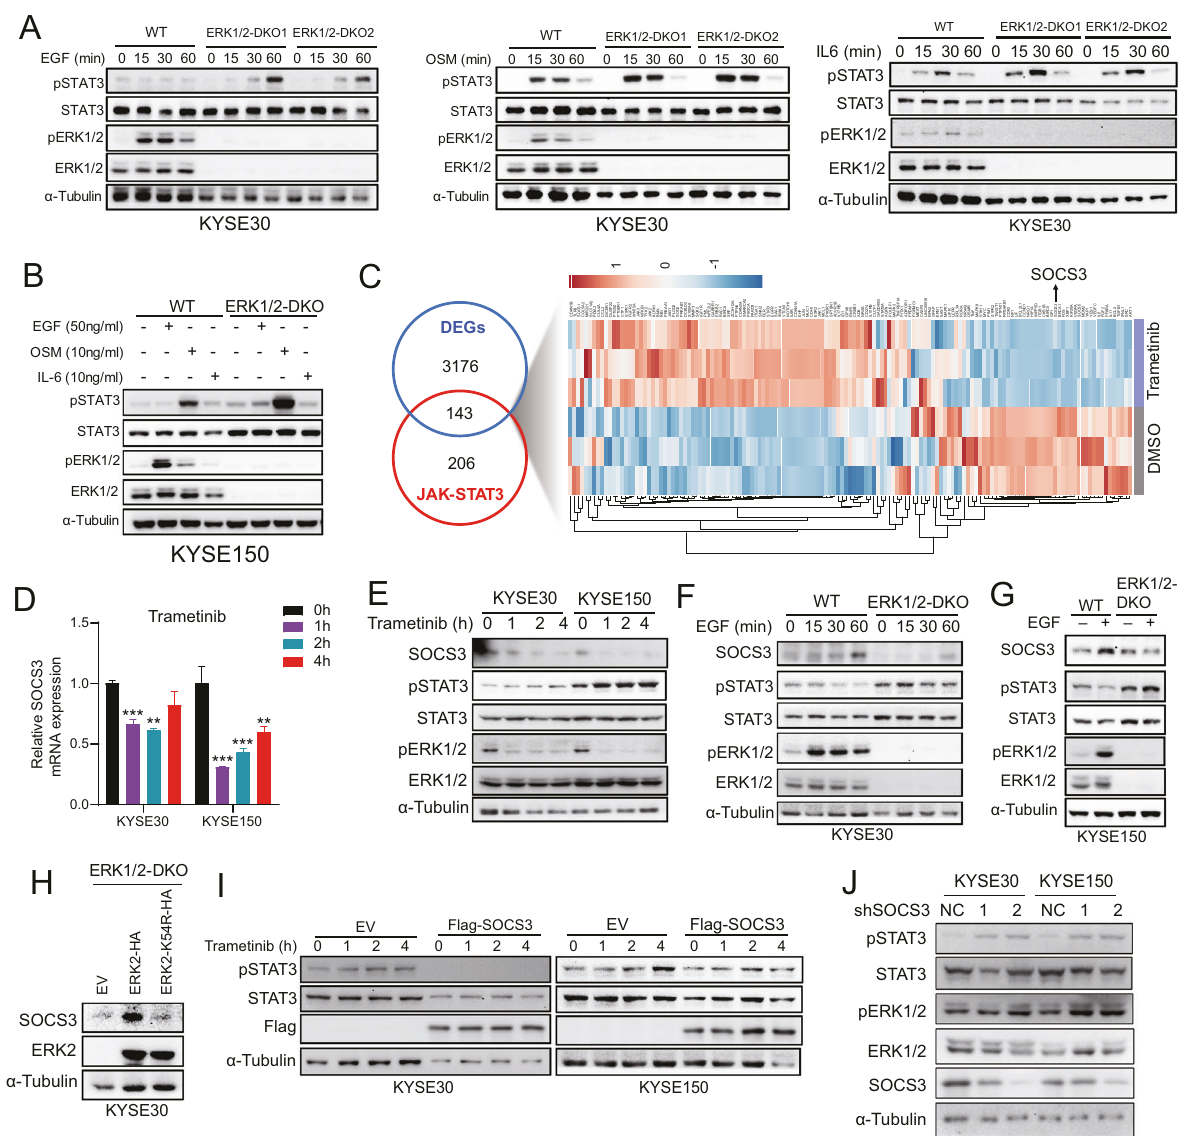
Fig. 4 MEKi results in STAT3 phosphorylation, which occurs through SOCS3 downregulation. A Western blotting shows the expression of pSTAT3 and pERK in KYSE30 WT, ERK1/2-DKO-1, and ERK1/2-DKO-2 after EGF (50 ng/ml), OSM (10 ng/ml), or IL-6 (10 ng/ml) treatment. B KYSE150 WT and ERK1/2-DKO cells were treated with EGF (50 ng/ml), OSM (10 ng/ml), or IL-6 (10 ng/ml) for 1 h. Expressions of pSTAT3 and pERK were determined using western blotting. C RNA-seq heat map analyses of differentially expressed genes (DEGs) involved in the JAK- STAT3 signaling pathway after trametinib or DMSO treatment. A fold change cutoff of log2 < − 0.58 or >0.58 and a p value cutoff of P < 0.05 were selected and overlapped for JAK-STAT3 signaling pathway genes. D qRT-PCR results show the transcription level of SOCS3 mRNA after trametinib treatment at various time points. Error bars represent the mean ± SD. ** P < 0.01, *** P < 0.001. E KYSE30 and KYSE150 cells were incubated with trametinib (1 μ M) for 0, 1, 2, 4 h, immunoblotted for SOCS3 expression. F , G Western blotting results show the expression of SOCS3 after EGF (50 ng/ml) treatment in WT, ERK-DKO KYSE30 ( F ) and KYSE150 ( G ) cells. H KYSE30 ERK1/2-DKO cells stably expressing EV, ERK2-HA, and ERK2-K54R-HA were used for western blotting to determine SOCS3 expression. I Western blotting results show the expression of pSTAT3 and Flag-SOCS3 in KYSE30 and KYSE150 cells transduced with EV or Flag-SOCS3. Trametinib (1 μ M) treatment was applied at various time points. J Western blotting results show the expression of pSTAT3 and pERK1/2 in KYSE30 and KYSE150 cells infected with shNC or shSOCS3 lentiviral with two target cell-dependent regulation and tumor cell develop different MEKi leads to autocrine activation of STAT3 via FGFR and IL-6 resistance mechanisms that drive a feedback loop for STAT3 receptors in mutationally activated EGFR-driven non-small-cell activation in response to stress. While the crosstalk between lung cancers [37]. STAT3 inhibition (STAT3i) resulting in ERK STAT3 and ERK signaling is complex, we sought to identify its role activation may be involved in other mechanisms in ESCC and has in mediating tumor cell target therapy in our ESCC models after been studied in pancreatic cancer [34]. Recently, Nagaraj et al. combined inhibition. Indeed, both STAT3 and MEKi resulted in showed an inverse correlation between pSTAT3 and pERK1/2 in decreased cell proliferation not only through inhibition of the pancreatic cancer, in which STAT3i results in ERK activation STAT3 and ERK signaling feedback but also by inducing through the TACE-AREG-EGFR axis [34]. These studies suggest that senescence via increasing cell cycle arrest and SASP (Fig. 6). the intracellular complexity of signaling pathway crosstalk allows